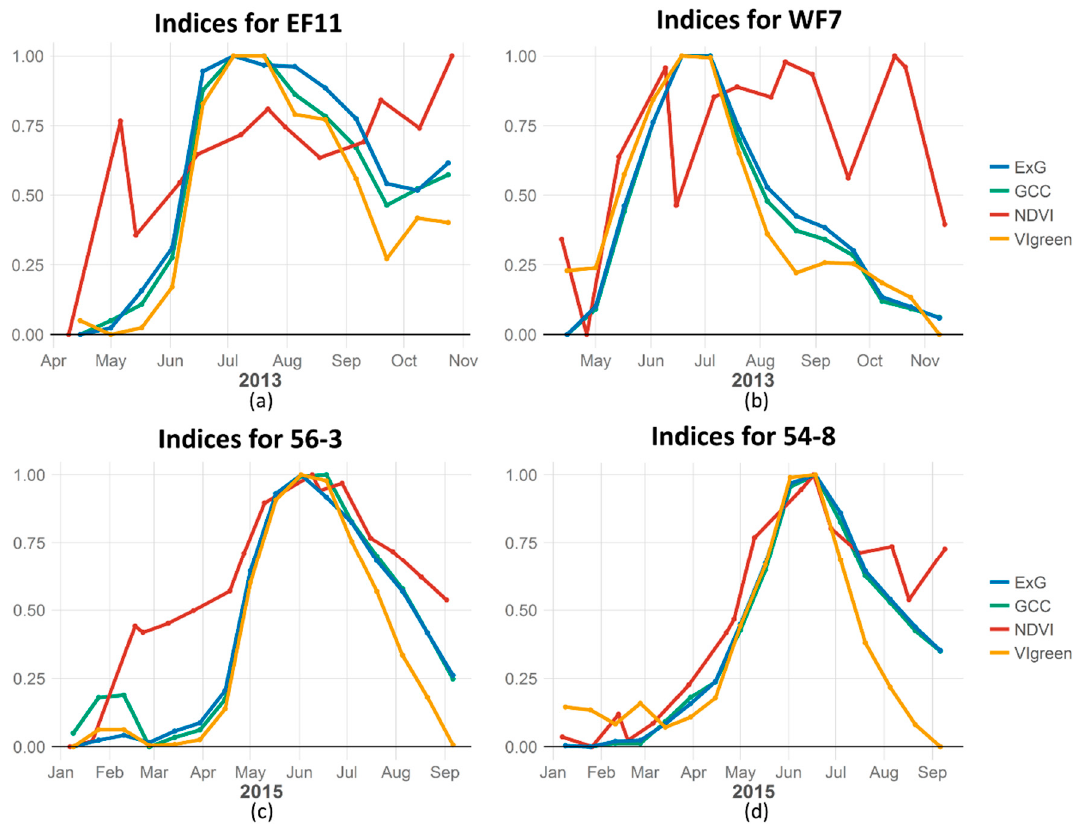
Figure 5. Comparison of camera derived 16-day averaged indices values from a network of digital cameras to MODIS NDVI values. The y-axis is a normalized scale from indices’ minimum to maximum values, while the x-axis is the temporal period of observations. Camera indices values are assigned to the midpoint of the 16-day period while MODIS NDVI values are assigned to the day of observation. Results from a forested site ( a ) and a mixed canopy site ( b ) in the Bitterroot study area are shown. Rangeland sites in the Idaho study area are shown in ( c , d ).